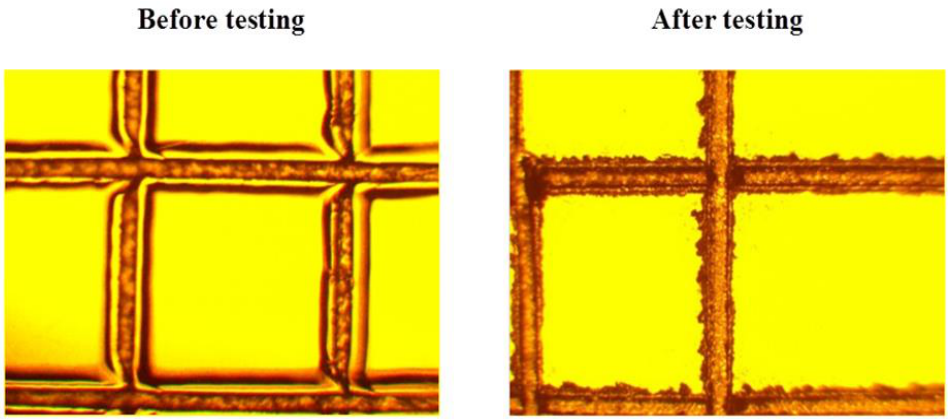
Figure 7. An example of slight deterioration in the adhesion strength of the coating for sample 1 treated according to option 2.